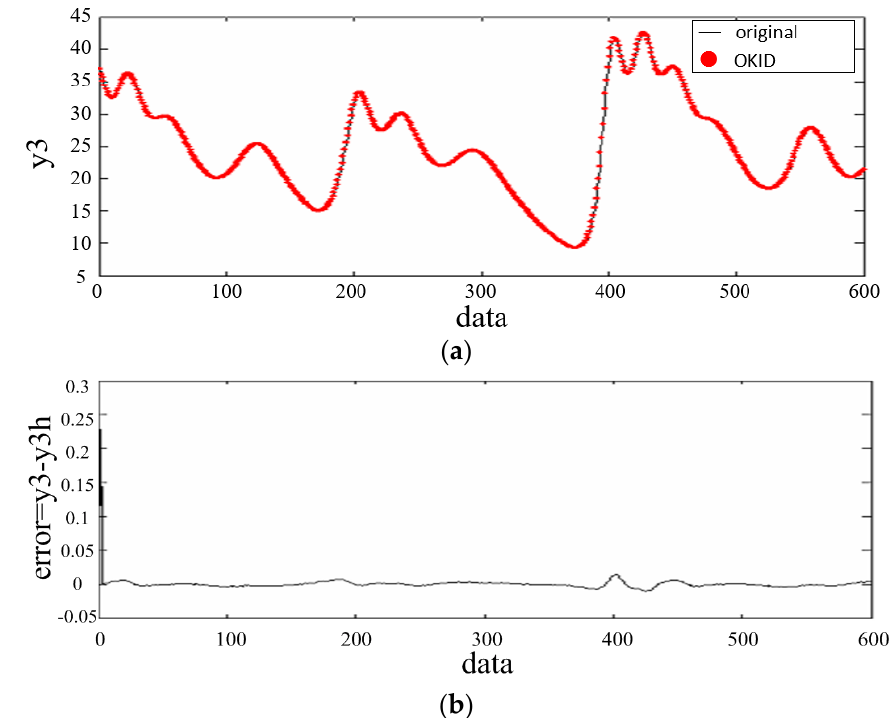
Figure 6. ( a ) Trajectories of y 3 ( t ) and ˆ y 3 ( t ) ; ( b ) Data of output error (cid:101) y 3 ( t ) .